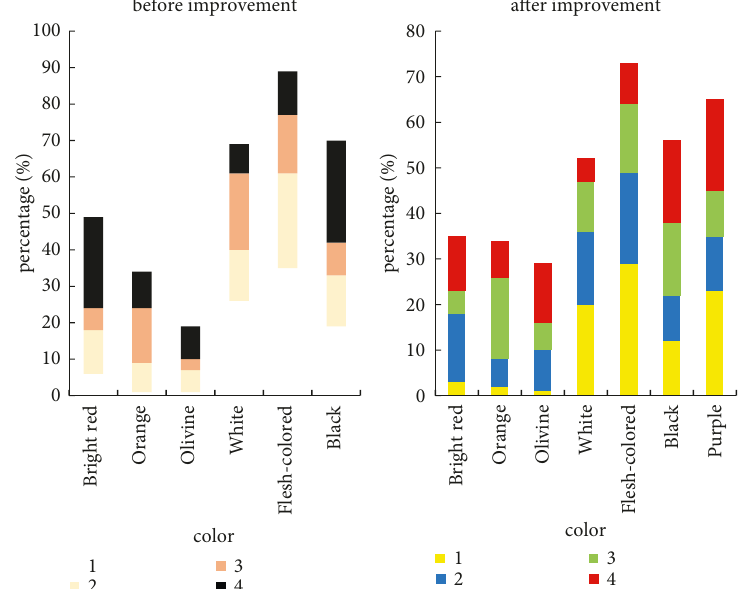
Figure 8: Comparison of the use of oil paints before and after the